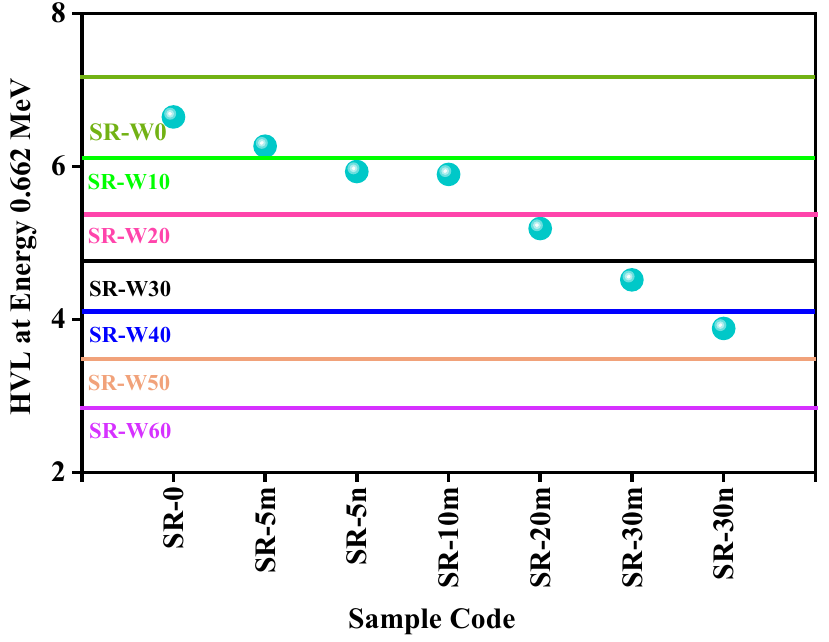
Figure 13. The comparison of HVL between the WO 3 -containing silicone rubber (SR-W0) systems with Bi 2 O 3 -containing silicone rubber (SR-0) systems at energy 0.662 MeV. 0, 10, 20, 30, 40, 50, and 60 wt% of WO 3 -nanoparticles contaminated silicone rubber (SR) systems (present study) have been compared to the silicone rubber (SR) systems with 0, 5, 10, 30, and 30 wt% of micro and nano sizes Bi 2 O 3 (literature data) fabricated by Abbas et al. [24]. In Figure 13, the blue colored spheres indicate the HVL values of the compared samples (taken from the literature data [24]) at 0.0662 MeV. This figure displays that SR-W50 and SR-W60 have lower HVL than the Bi 2 O 3 -containing silicone rubber (SR) systems. The comparison of HVL between the WO 3 -containing silicone rubber (SR-W0) system with iron ore-containing silicone rubber (Sdt-0) systems [26] has been presented in Figure 14 for energy 0.662 MeV. In Figure 14, red colored balls indicate the value of compared samples’ (literature data—[26]) HVL at energy 0.0662 MeV. Silicone rubber SR-W60 (prepared sample) has represented the lowest HVL comprising pure and up to 67 wt% of iron ore added to silicone rubber (literature data—[26]).